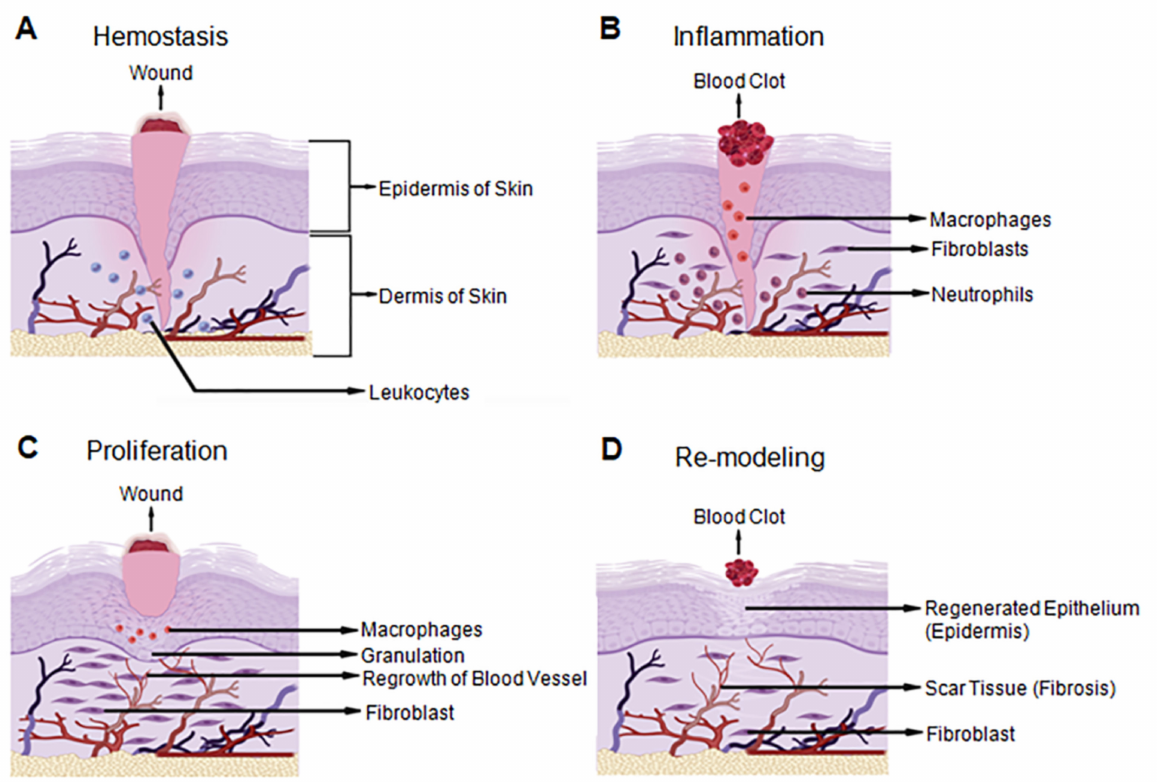
Figure 1. Wound healing stages demonstrated on the three layers of human skin. There are four- tightly controlled stages of wound healing in the human body: ( A ) Hemostasis is the first stage and acts as the first response when blood vessels are damaged and blood leaks into the wound area; ( B ) Inflammation is the second phase and involves vasodilation which helps to prevent infection by triggering the formation of a blood clot and cleaning the wound site with leukocytes; ( C ) Prolifer- ation is the tissue development phase of wound healing. Granulated tissue with an extracellular matrix (ECM) composed of new connective tissue and blood vessels is formed in the presence of an appropriate amount of moisture and oxygen; ( D ) Re-modeling is the last stage and is regulated by differentiated myofibroblasts. The ECM of the wounded tissue is reconstituted similar to normal tissue. Many of the newly produced capillaries regress and restore the vascular density of the wound to normal. Created with BioRender.com accessed on 13 November